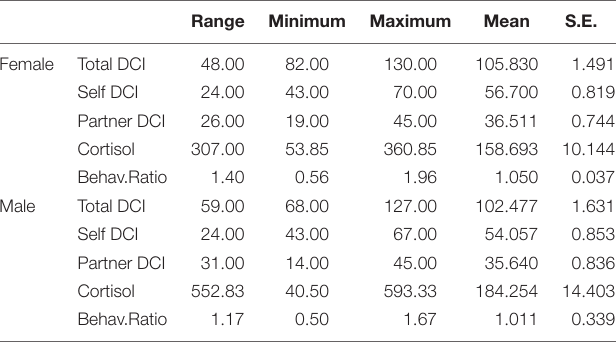
TABLE 1 | Descriptive statistics of dyadic coping, cortisol concentration, and behavioral